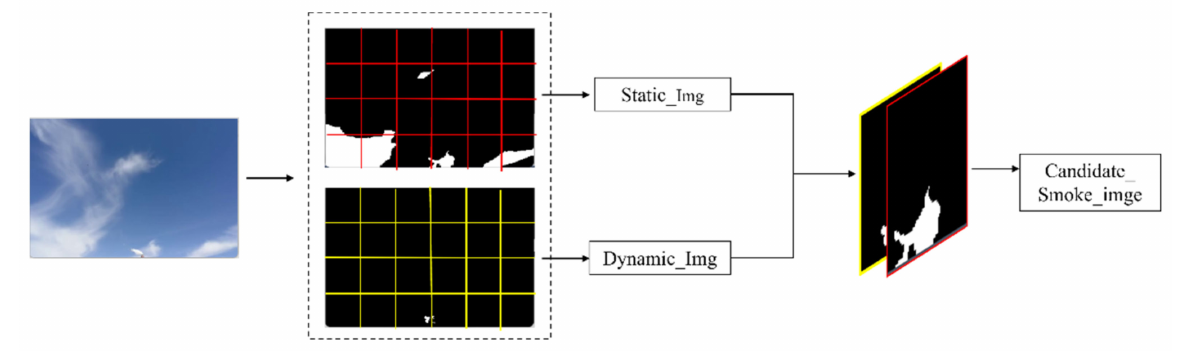
Figure 2. Fusion